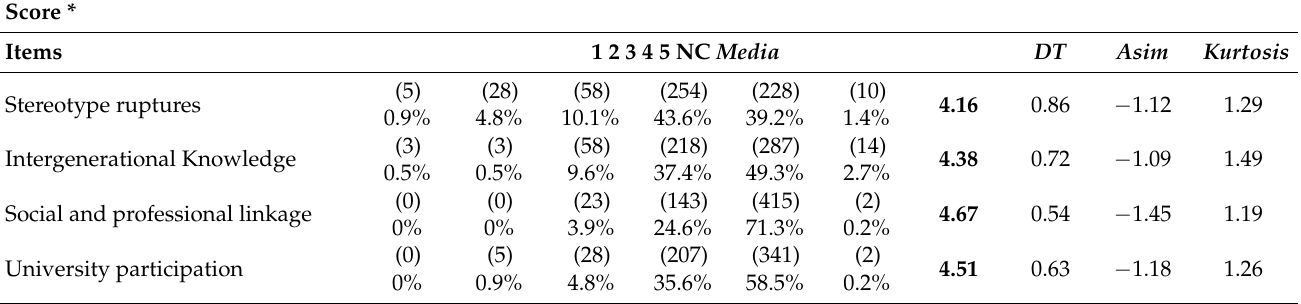
Table 2. Participant’s questionnaire evaluation of statistical items about the intergenerational project (N =